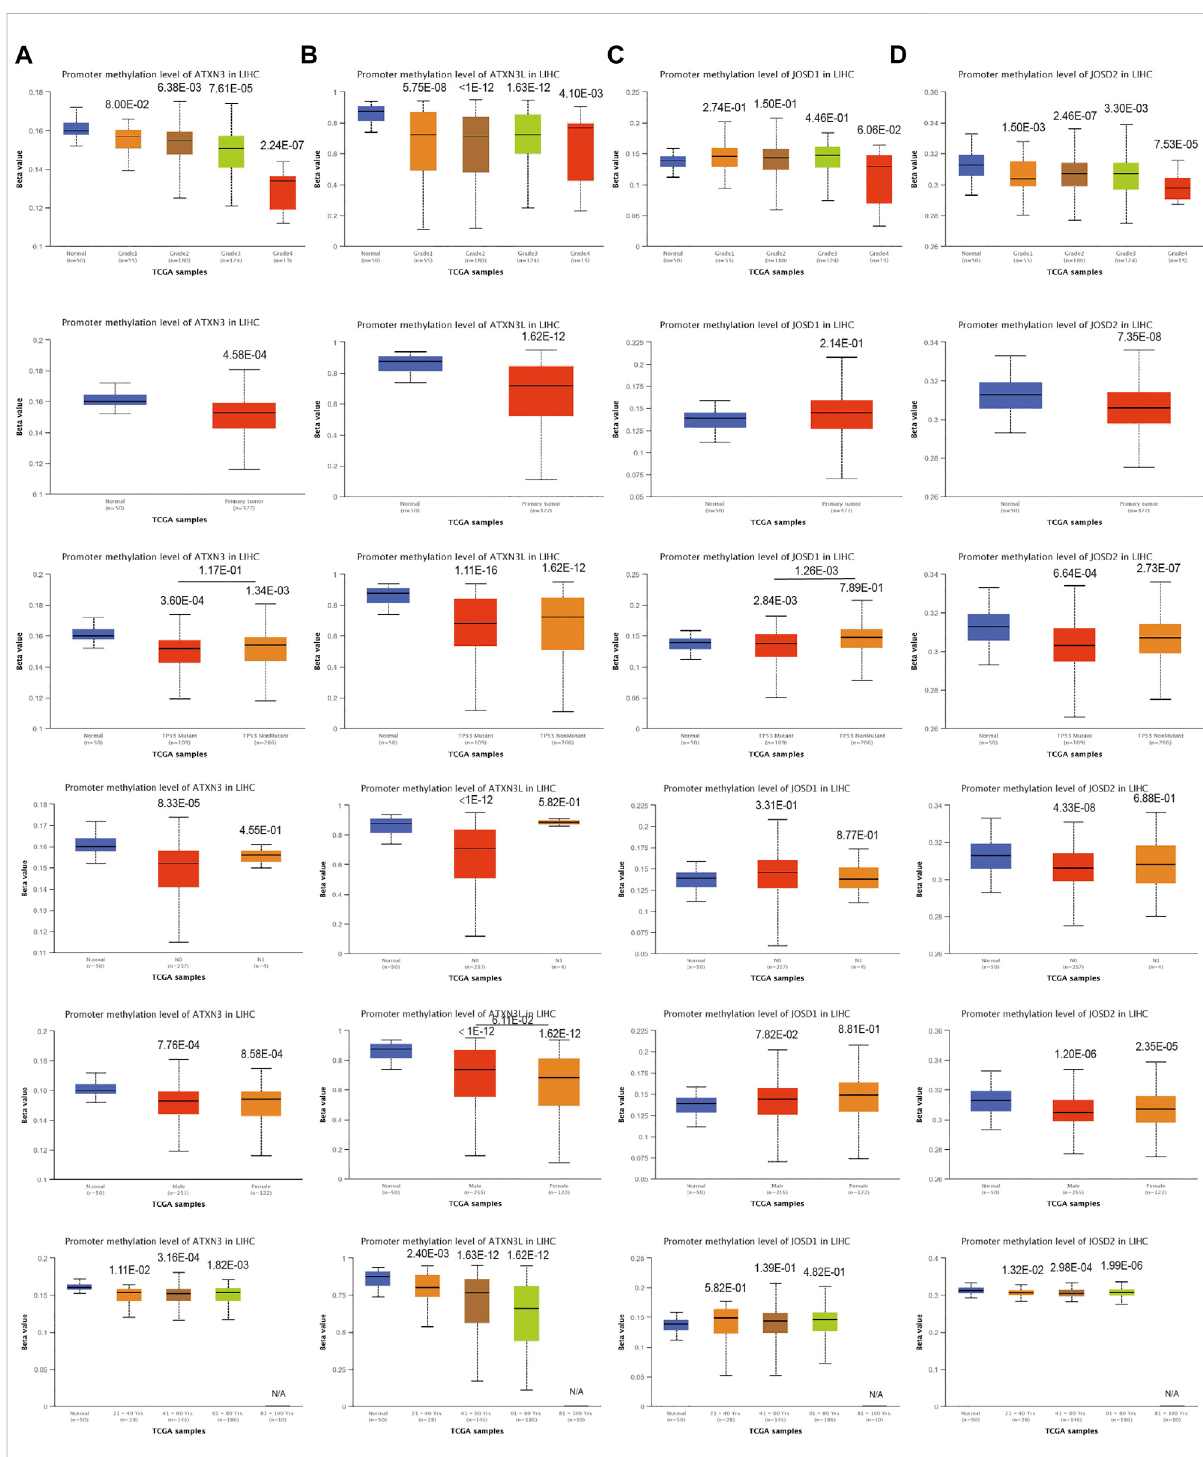
FIGURE 3 (A – D) CorrelationanalysisbetweenmethylationlevelofMJDsfamilymembersandHCCpatientsclinicalcharacteristics.TheMJDsmethylation level in HCC patients classi fi ed by histological grades, sample types, TP53 mutations, lymph node metastaticstatus, genders, and years were